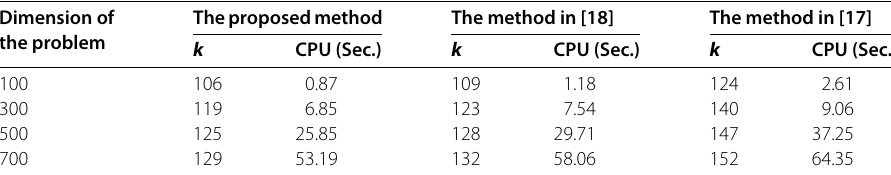
Table 2 Numerical results for problem (4.1) with r 1 = 1, r 2 = 10 Dimension of the problem